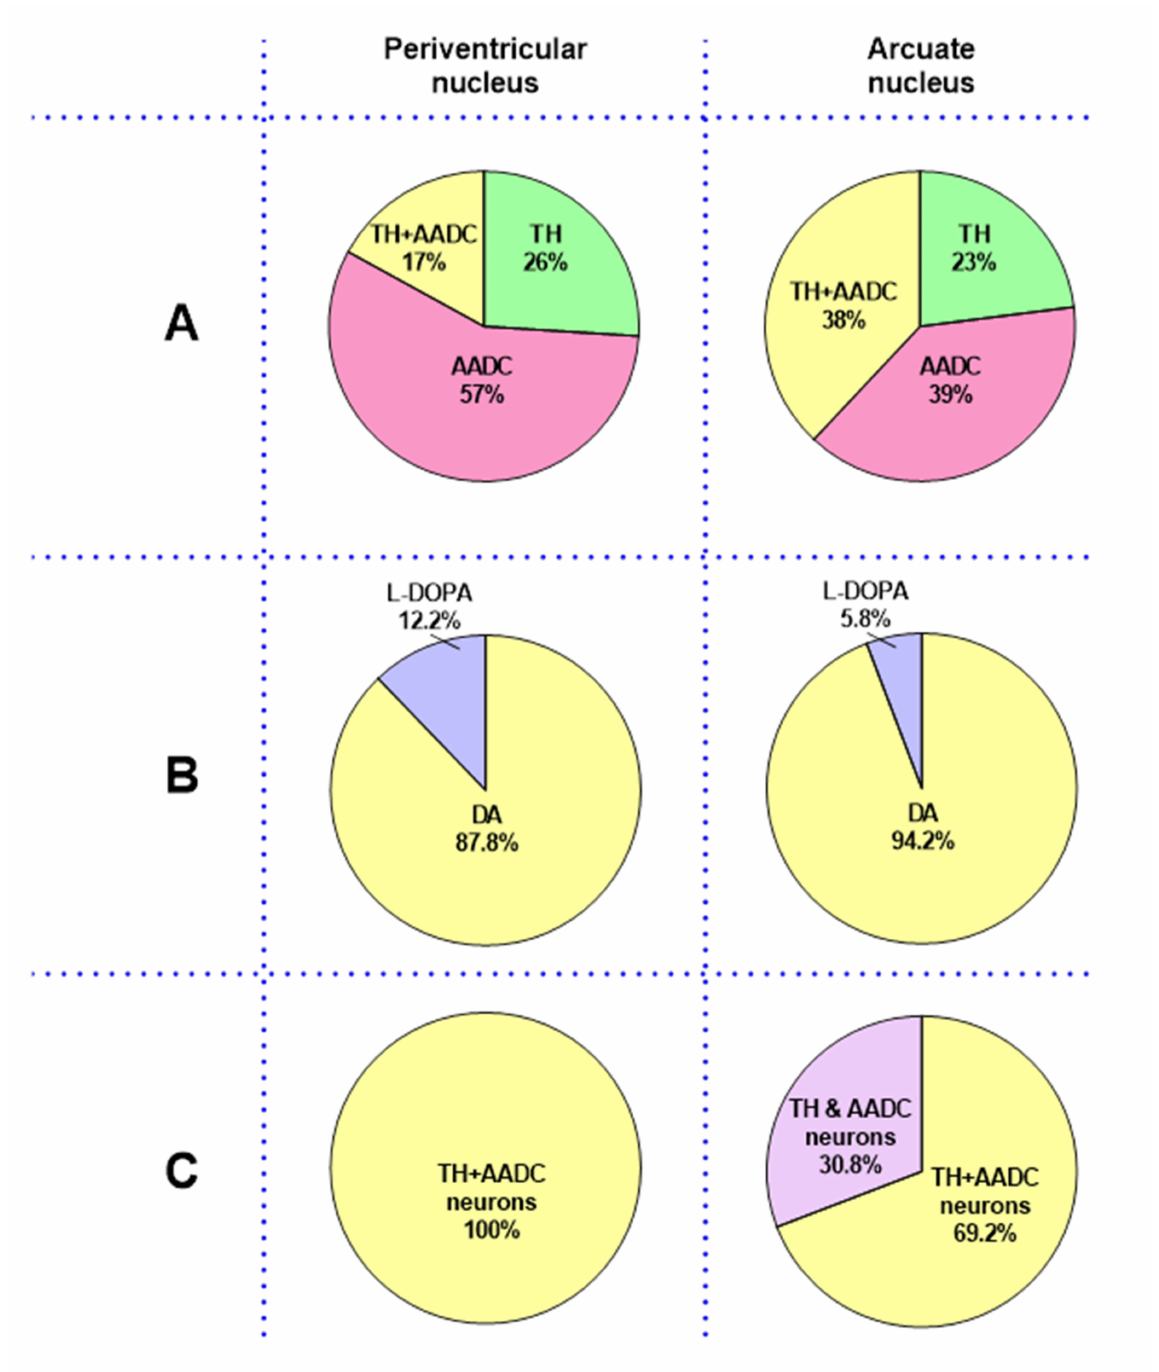
Figure 9. Comparative analysis of the periventricular nucleus (PeVN) and the arcuate nucleus (AN) as brain centers containing neurons expressing one or both dopamine (DA)-synthesizing enzymes in rats aged 30 days: ( A ) proportions of monoenzymatic (TH or AADC) and bienzymatic (TH + AADC) neurons in the PeVN and AN (Ershov et al., 2002) in relation to all neurons expressing enzymes of DA synthesis, taken as 100%; ( B ) proportions of DA and L-DOPA in each nucleus in relation to the total content of each substance, taken as 100%; ( C ) proportions of DA synthesis by bienzymatic neurons (TH + AADC) and monoenzymatic neurons (TH & AADC) in cooperation in the PeVN and AN in relation to the total synthesis of DA, taken as 100%. AADC, aromatic L-amino acid decarboxylase; TH, tyrosine